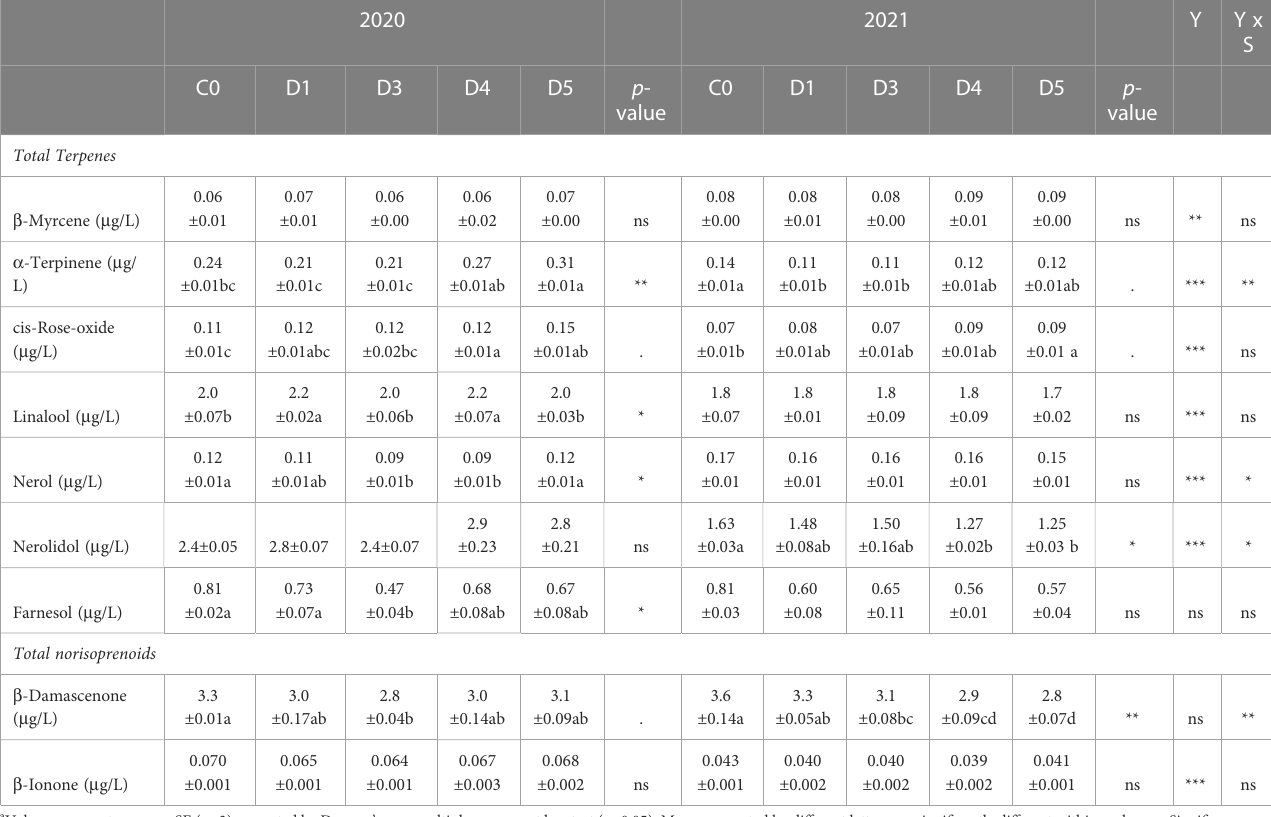
(Figure S1). Alcohol percentage and ketones were also positively correlated to TPI and acids, although less so than CI. Ketones also were very strongly positively correlated with higher alcohols, while higher alcohols were less strongly correlated to acids. Conversely, fl avonols were strongly negatively correlated with acetate esters and other esters in wines. Norisporenoids and pH were less negatively correlated to acetate esters. Fatty acid ethyl esters particularly showed to be negatively correlated with TA.